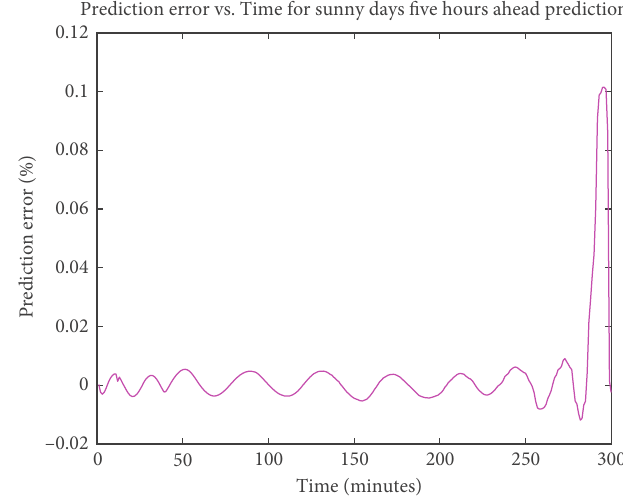
Figure 17: Prediction error vs. time for sunny day fi ve-hour-ahead